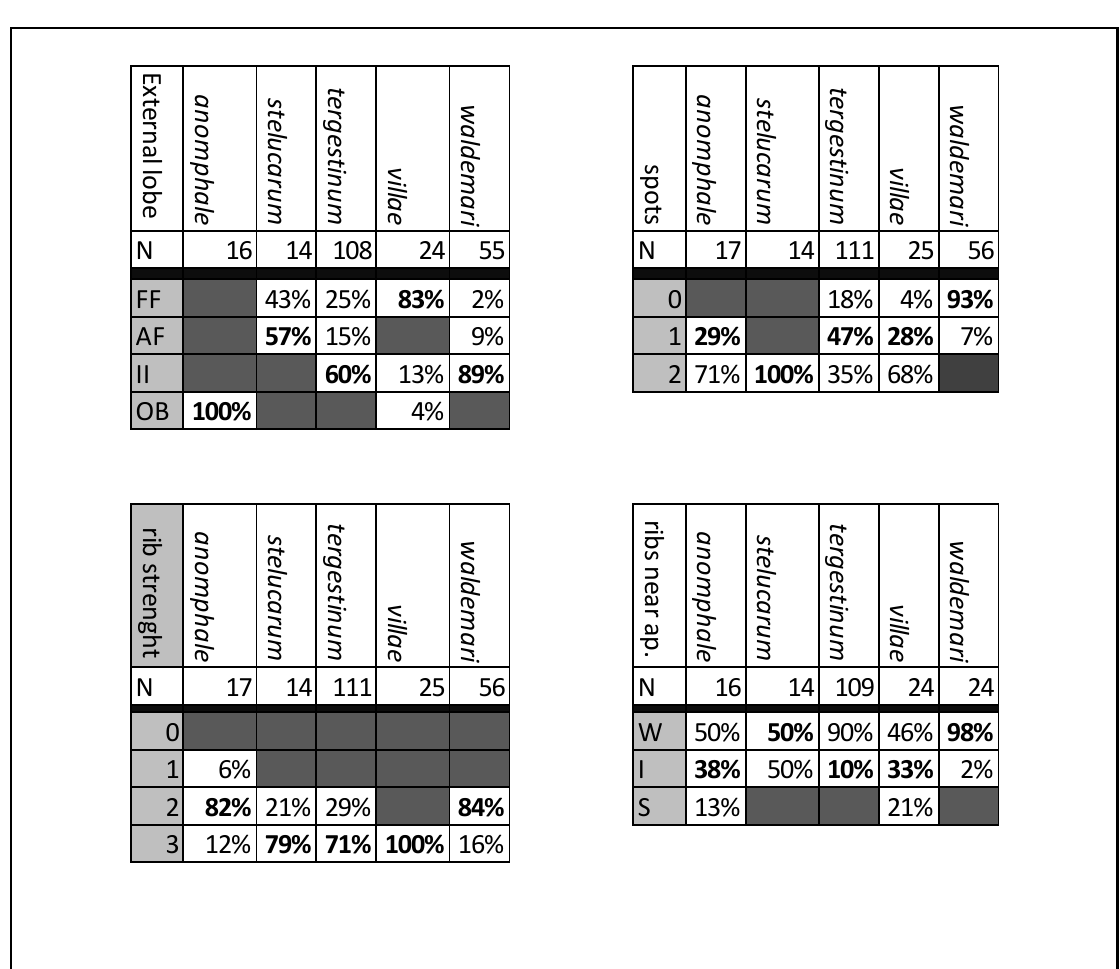
Table 3. Percentage of the analyzed female specimens presenting the shell feature as explained in Fig. 3 within each species of Clessiniella Zallot et al ., 2015. In bold the feature status as presented by the types. Abbreviation: N = number of analyzed